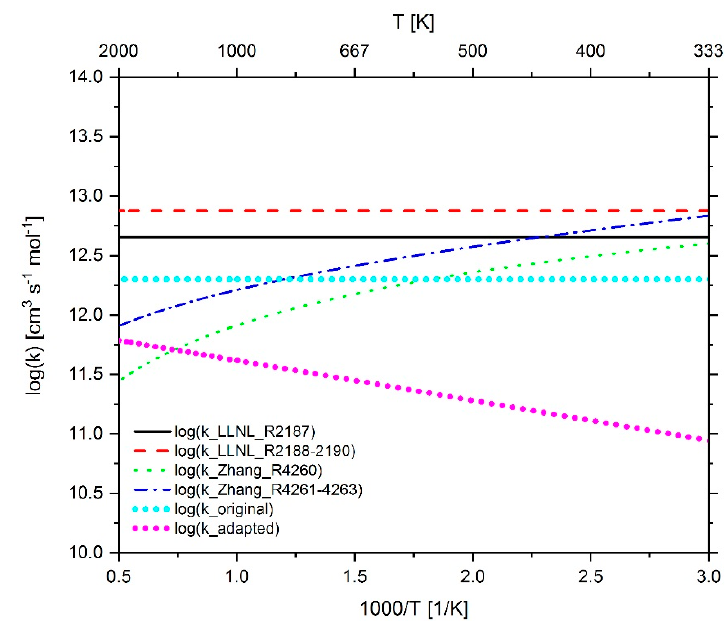
Figure 26. Comparison of the reaction rate coefficient of reaction 297 ( n -C 7 H 15 + O 2 ↔ n -C 7 -QOOH) before and after adaptation as well as the rate coefficients of the reaction C 7 H 15 + O 2 ↔ C 7 H 15 O 2 in the mechanism of LLNL [23] and Zhang et. al . [21].